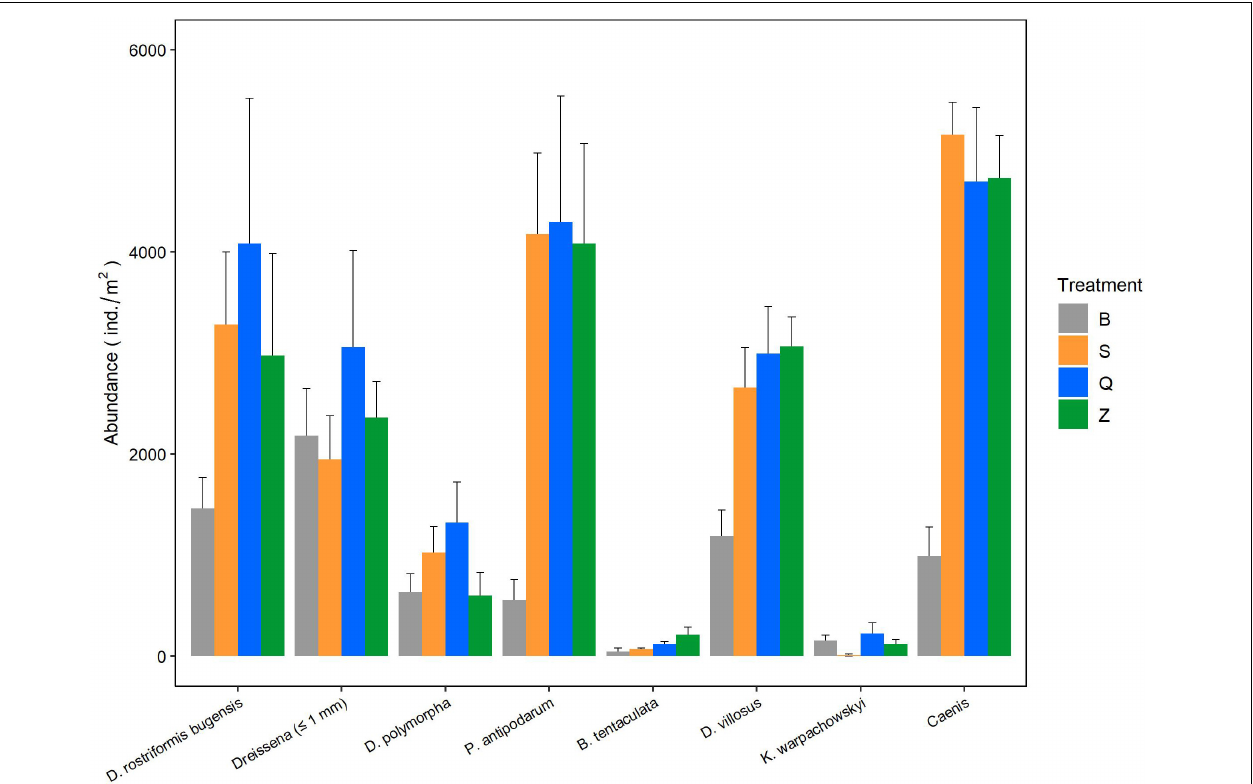
FIGURE 1 | The abundance of abundant newly settled macroinvertebrates in four different treatments. Taxa that can be identified to species or genus level are presented. Error bars indicate standard errors.